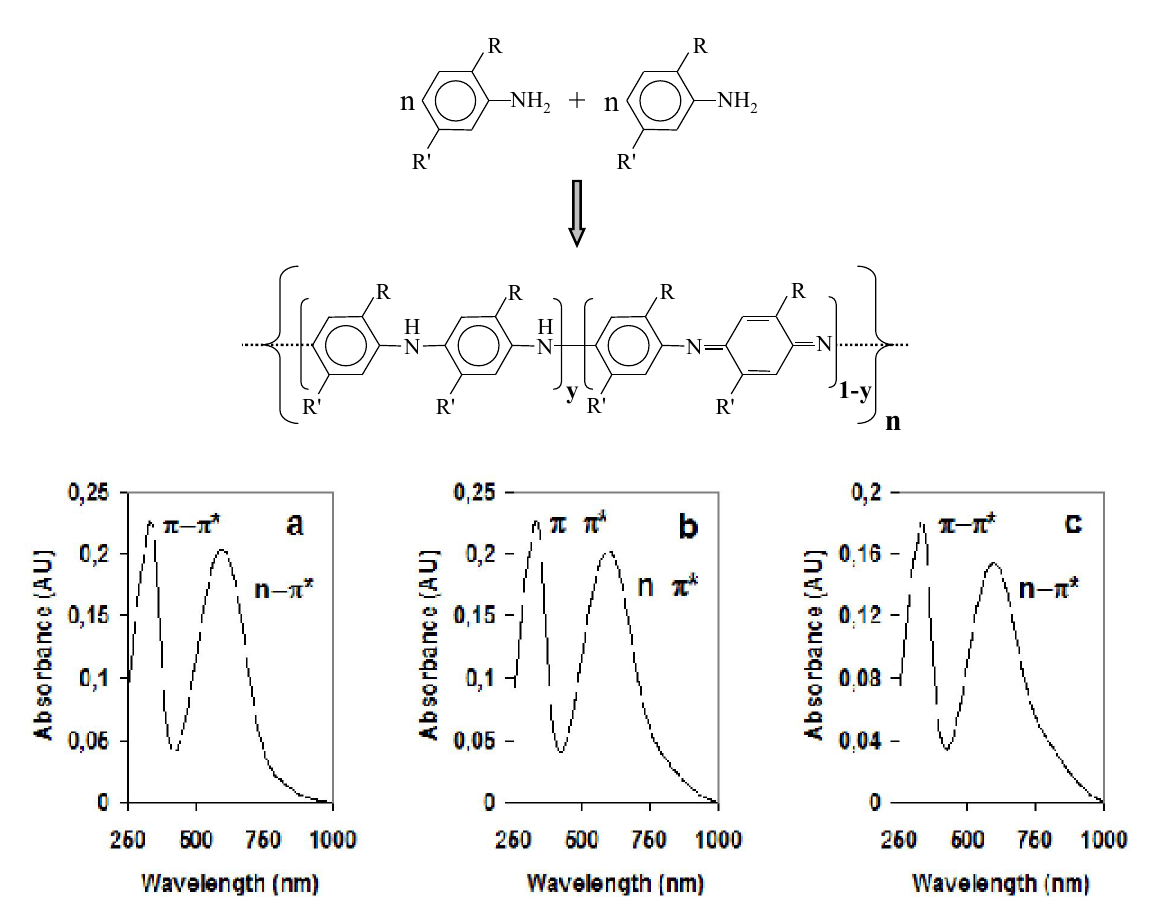
Figure 3. Above: Scheme of the synthesis leading to the formation of a repeat unit starting from monomers. Based on the fraction of imine nitrogen groups per repeat unit, it is possible to obtain different reduced/oxidized polymer chains as follows: Fully reduced form (leucoemeraldine base) for y = 1; fully oxidized form (pernigraniline base) for y = 0; half oxidized form (emeraldine base) for y = 0.5. Below: UV-vis spectra of materials in the undoped form based on disubstituted conducting polymer (PDMA and PDOA): PDMA pure conducting polymer; PDMA-MWNTs nanocomposite material;